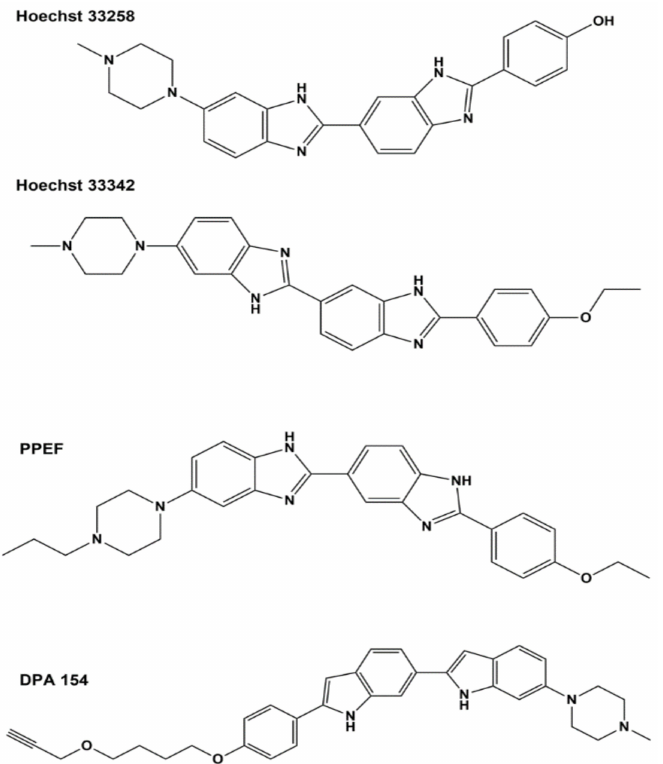
Figure 2. Structures of bis-benzimidazoles Hoechst 33258, Hoechst 33342, 2 (cid:48) -(4-ethoxyphenyl)-5-(4- propylpiperazin-1-yl)-1H,1 (cid:48) H-2,5 (cid:48) -bibenzo[ d ]imidazole (PPEF) and DPA